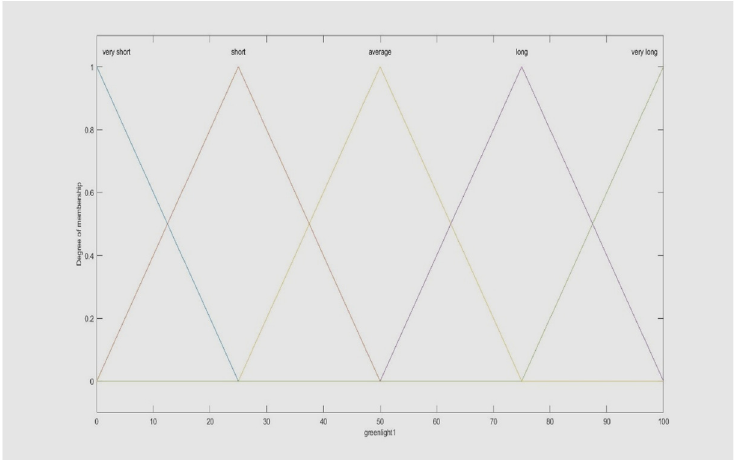
Figure 8. Output from fuzzy regulator for junction 2 with five linguistic values. The second output of the fuzzy system u 2 is calculated using Equation (1).